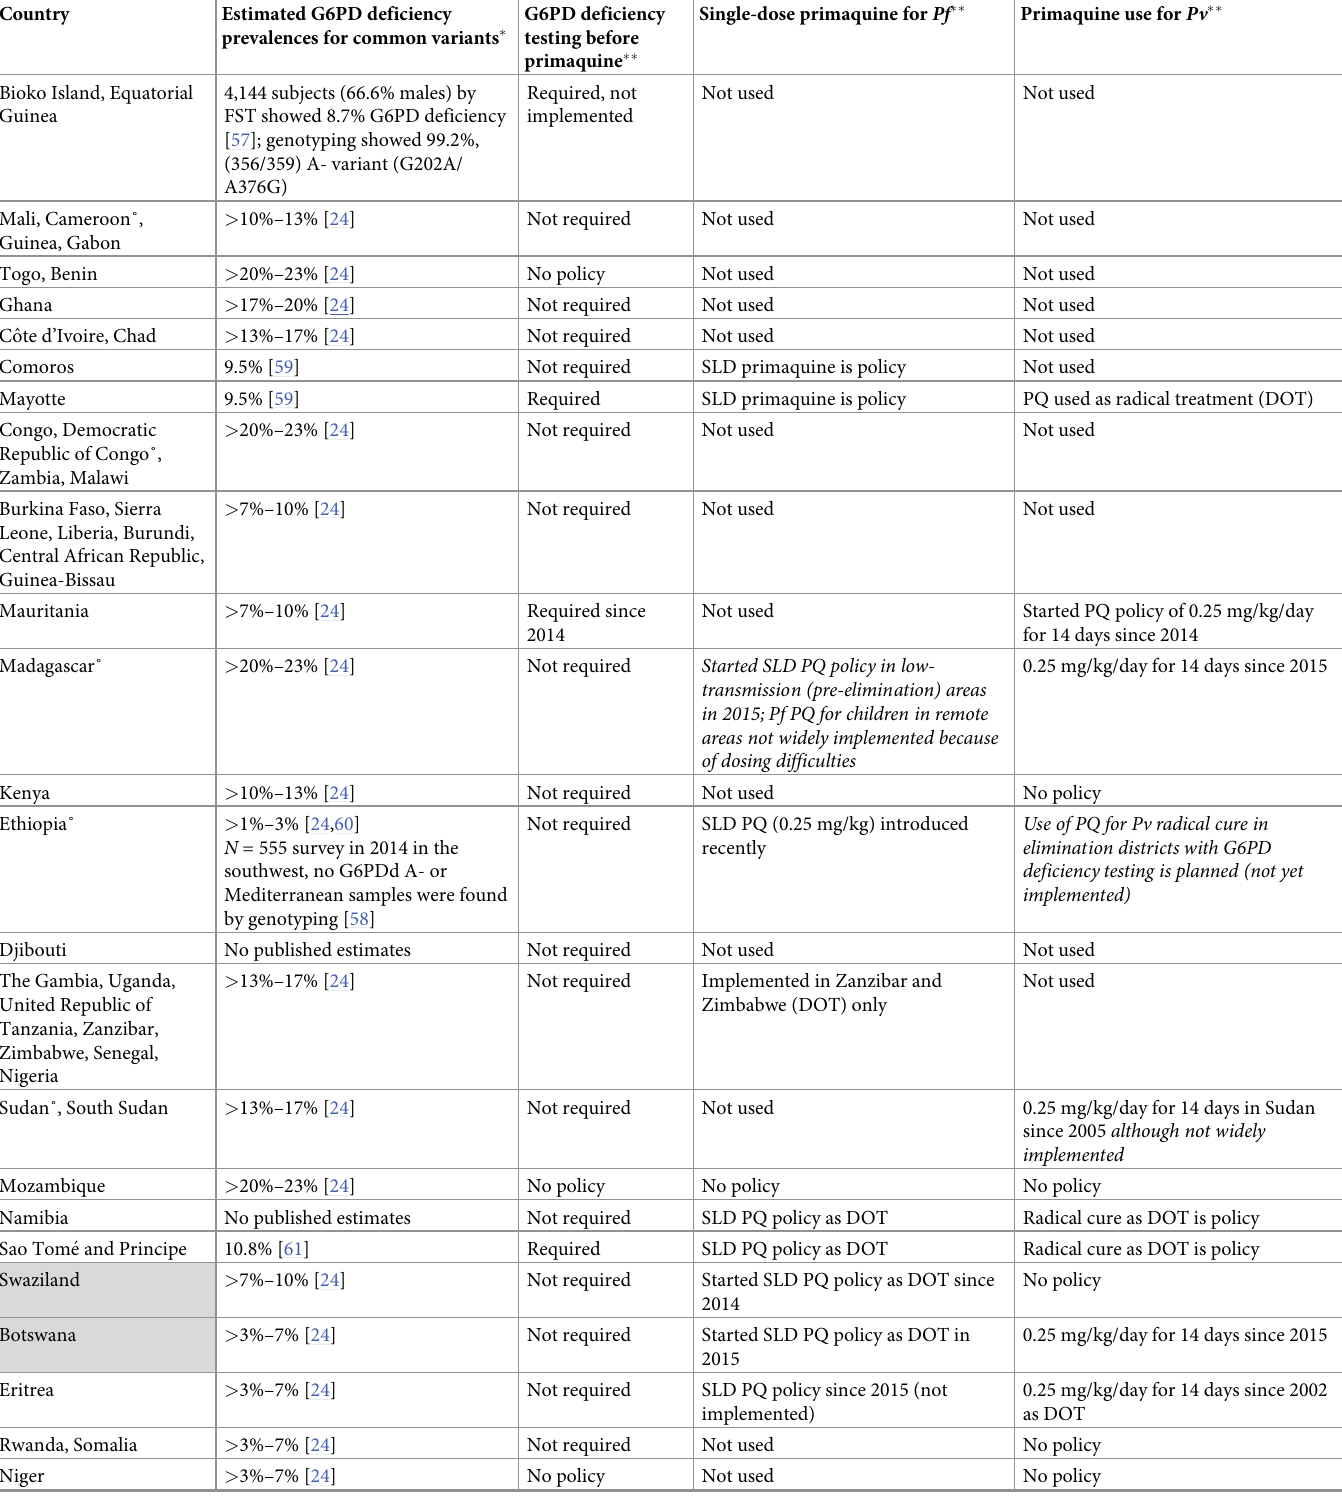
Table 4. G6PD deficiency prevalences (cid:3) , testing, and primaquine policies in African malaria-endemic countries. Country Estimated G6PD deficiency G6PD deficiency Single-dose primaquine for Pf (cid:3)(cid:3) Primaquine use for Pv prevalences for common variants (cid:3) testing before primaquine (cid:3)(cid:3)